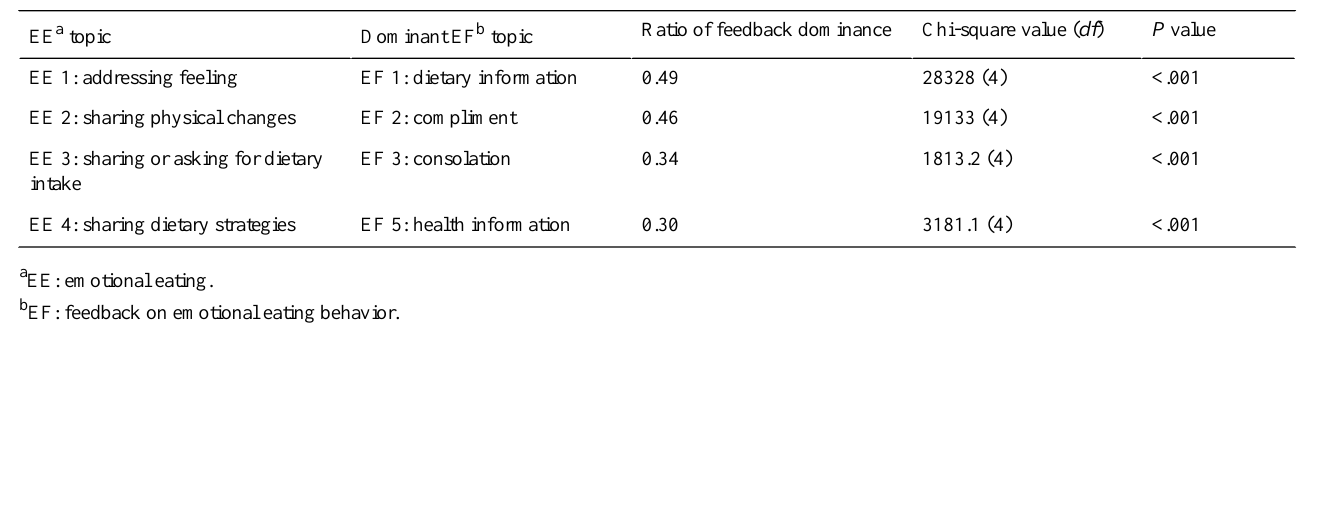
Quotes from online postsFrequent wordsTopicNumber